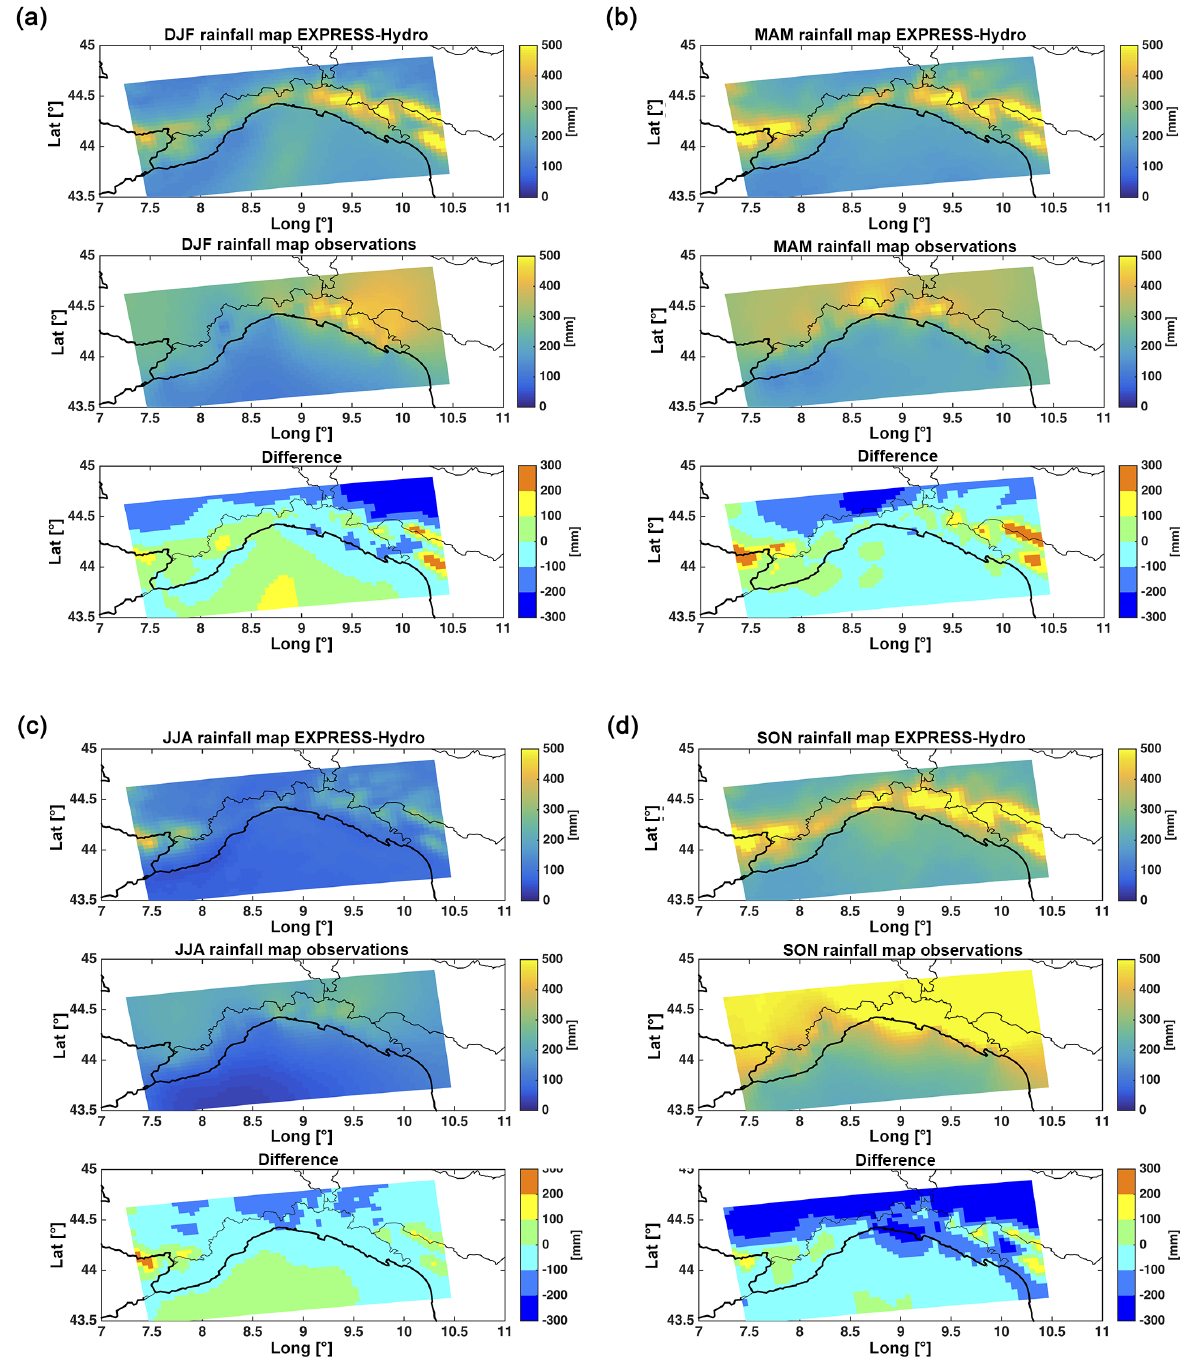
Figure 3. The figure shows the average DJF (a) , MAM (b) , JJA (c) and SON (d) rainfall maps over Liguria. For each season three maps are shown: the EXPRESS-Hydro rainfall map, observed rainfall map and difference map in mm.